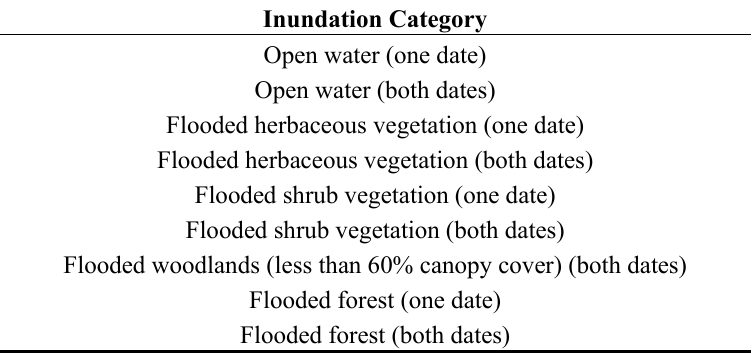
Figure 9. Location shown in Figure 3 by yellow box where horizontal extent is 3500 km. ( a ) Melack and Hess inundation classification (mid-90s); ( b ) ALOS inundation classification (2007–2009). Yellow—always inundated vegetation; off-yellow—occasionally inundated vegetation; dark blue—always open water; medium blue—occasionally open water; brown (ALOS only)—high topographic slopes. Table 3. Inundation categories from Melack and Hess